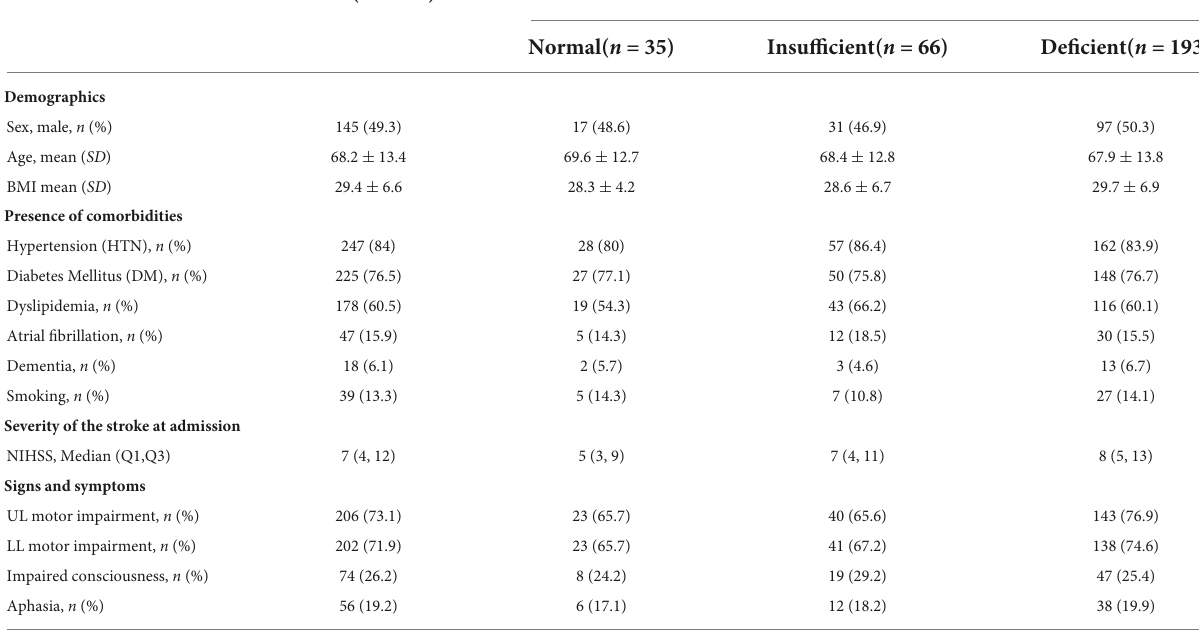
TABLE 1 Characteristics of study subjects at admission according to vitamin D